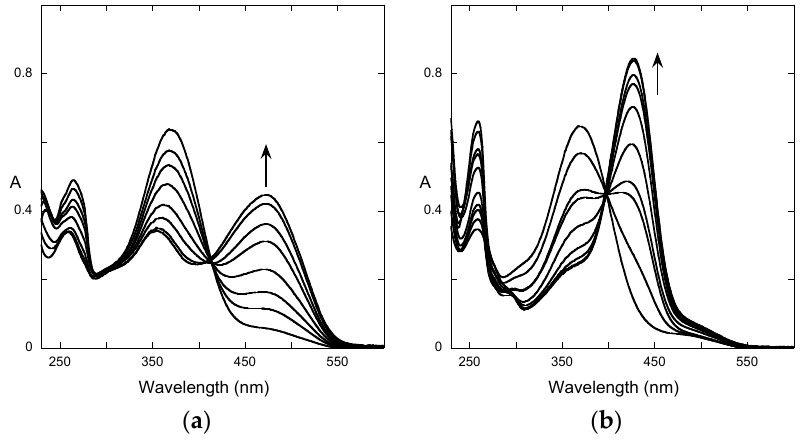
Figure 8. Equilibrated spectra of compound 3 (7-hydroxyflavylium) in the presence of different concentrations of CB7 (up to 2.5 mM) at pH 6 ( a ); and pH 4 ( b ). With permission from ACS reference [22].